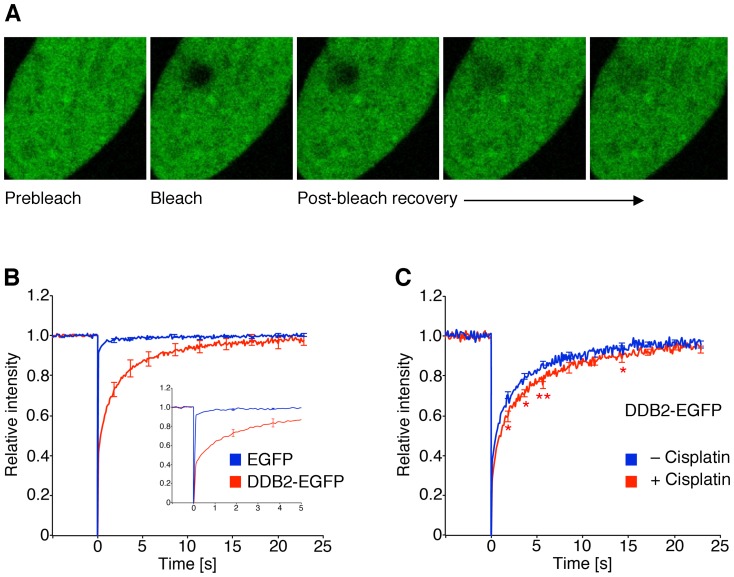
Analysis of repair protein dynamics in living cells.(A) A region of interest of ∼4 μm2 was photo-bleached and the fluorescence recovery within this area was monitored over a time frame of 23 seconds. Simultaneously, a reference area of the same size was monitored to correct for overall bleaching and the resulting data were normalized to the pre-bleach intensity. (B) Quantitative FRAP recordings determined in fibroblasts transfected with expression vectors coding for the DDB2-EGFP fusion or the EGFP moiety alone (N = 30; error bars, S.E.M.). (C) Recognition of cisplatin-DNA adducts by UV-DDB revealed by FRAP analyses. Human fibroblasts transfected with the DDB2-EGFP construct were pre-incubated with 5 μM cisplatin. The resulting FRAP curves were compared with those of untreated controls. Asterisks, statistically significant differences between cisplatin-treated cells and untreated controls (N = 50; *p<0.05; **p<0.01).